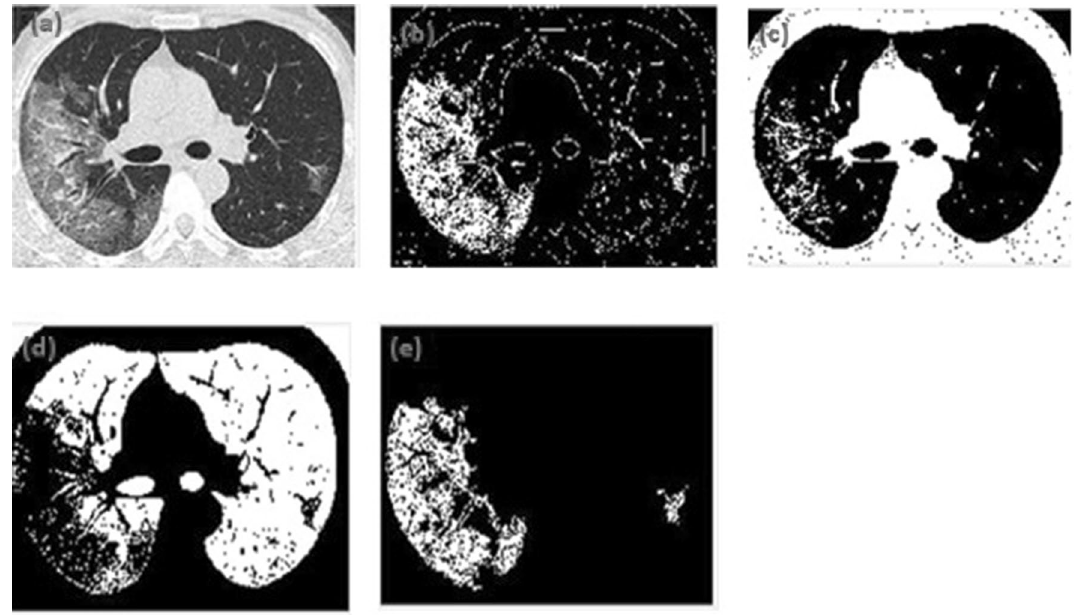
Figure 1. k -means segmentation of COVID CT image ( a ) original CT image of COVID-19 patient, ( b ) cluster depicting the region of interest, ( c ) cluster that detects several edges in the image, including the lungs, vessels, and some of the ground glass opacities, ( d ) cluster depicting uninfected regions of the lungs, ( e ) final k -means image highlighting lung infection such as ground-glass opacities.